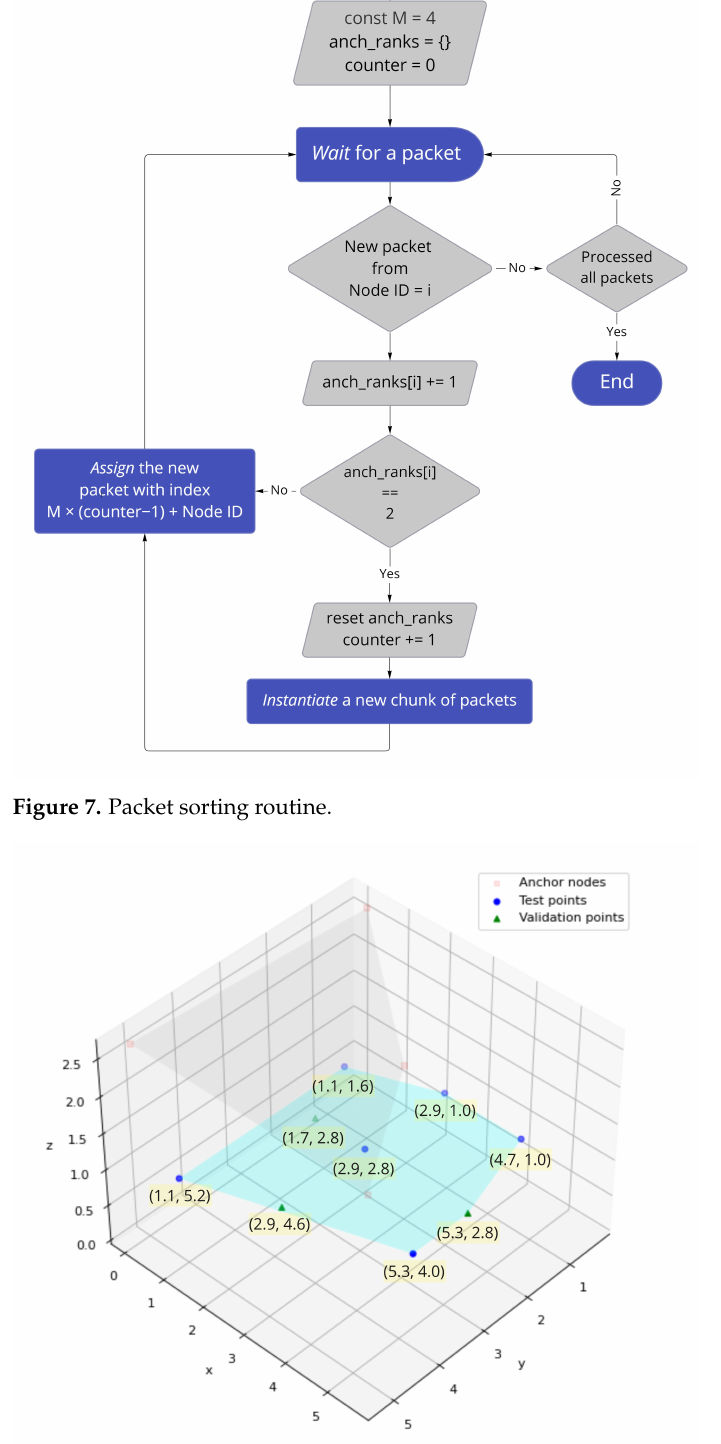
Figure 8. Locations of test and validation